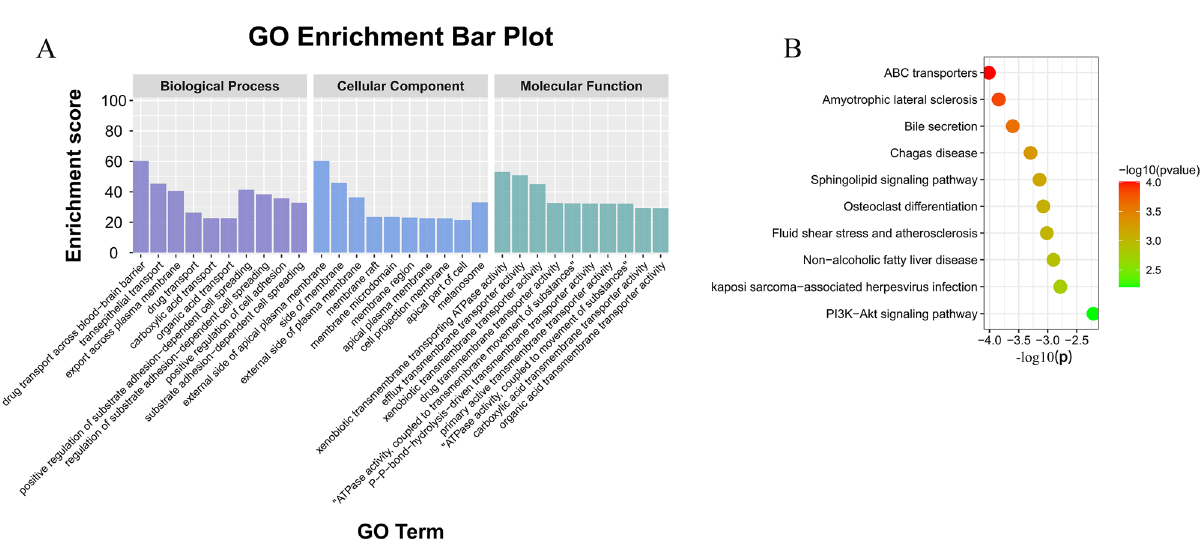
Figure 7. GO and KEGG enrichment analysis of 9 hub targets. A and B represent the first 10 entries enriched by GO and KEGG,